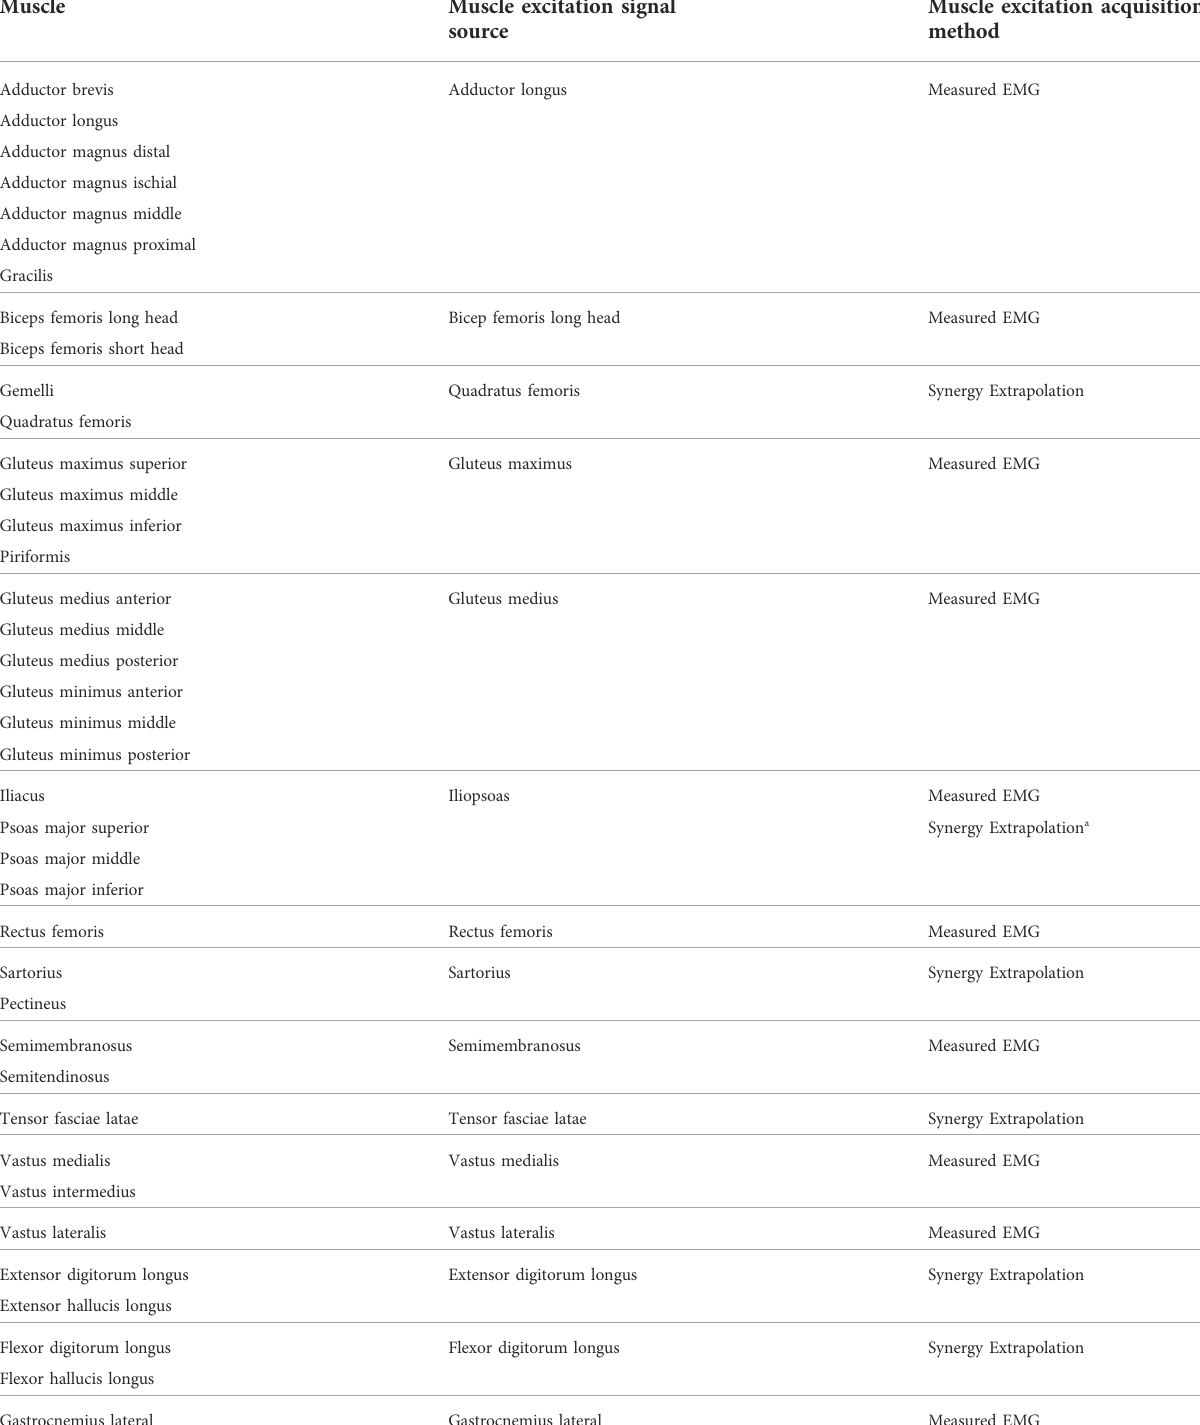
TABLE 1 List of lower extremity muscles in the musculoskeletal model, the muscle excitation signal sources, and the method used to acquire the muscle excitation